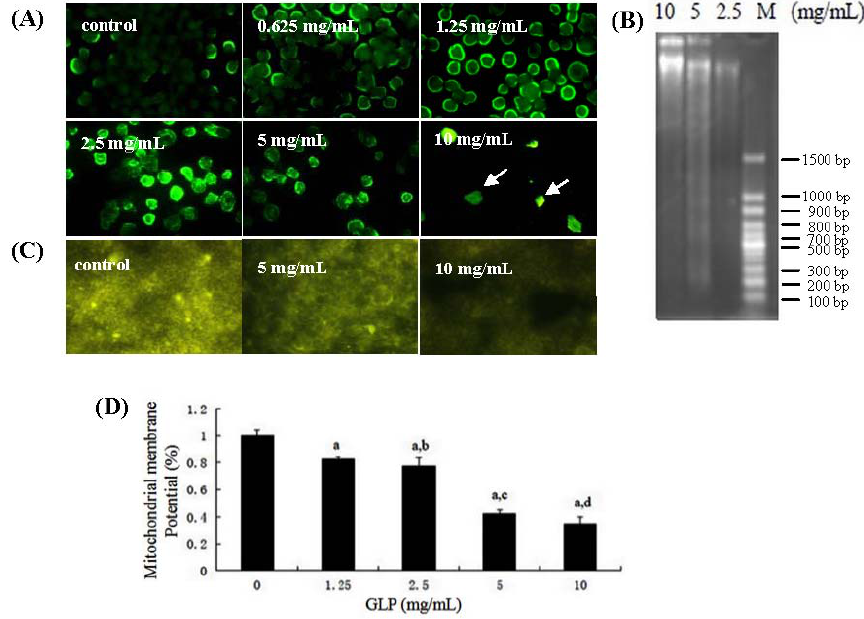
Figure 4. Effects of GLP on apoptosis in HCT-116 cells. ( A ) Apoptotic cells measured by Hoechst 33,258 staining after treatment with GLP for 48 h under a